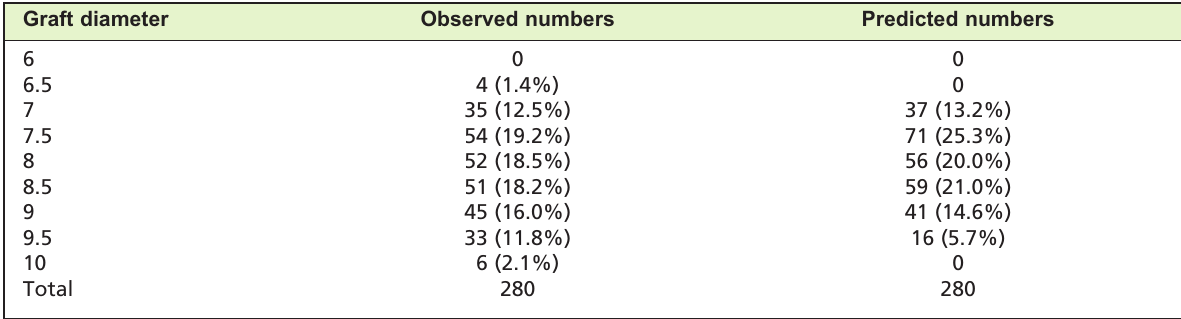
Graft size Table IV: